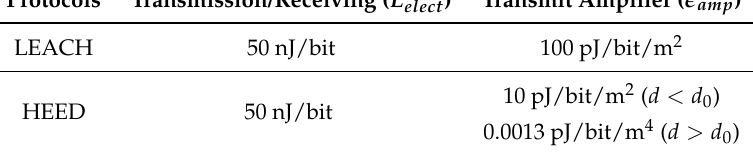
Table 7. Energy Dissipated for LEACH and